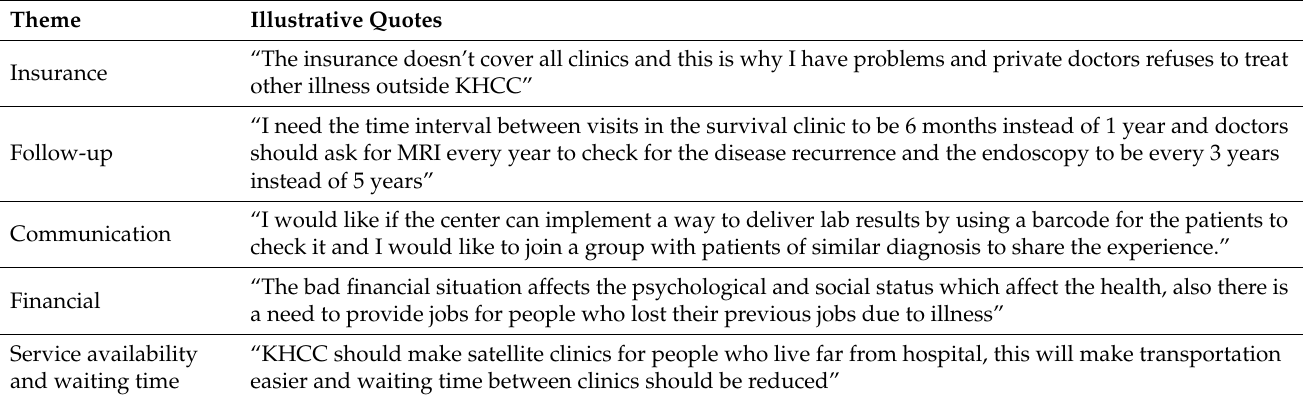
Table 7. Other needs identified by cancer survivors using open-ended